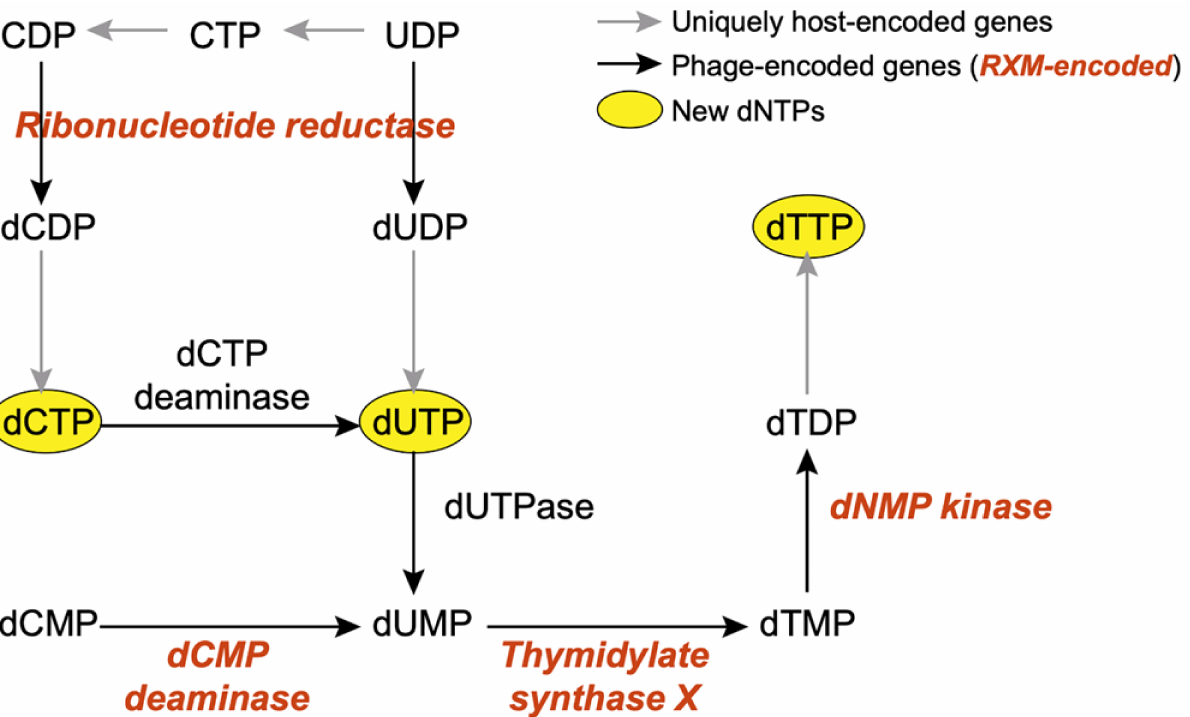
Figure 5. A diagram showing how phages hijack host nucleotide biosynthesis to enhance the viral biosynthetic capacity. Phages encode abundant genes (black arrows) to promote the production of new dNTPs (yellow ovals). In the RXM genome, a few related genes are recognized (highlighted in bold red